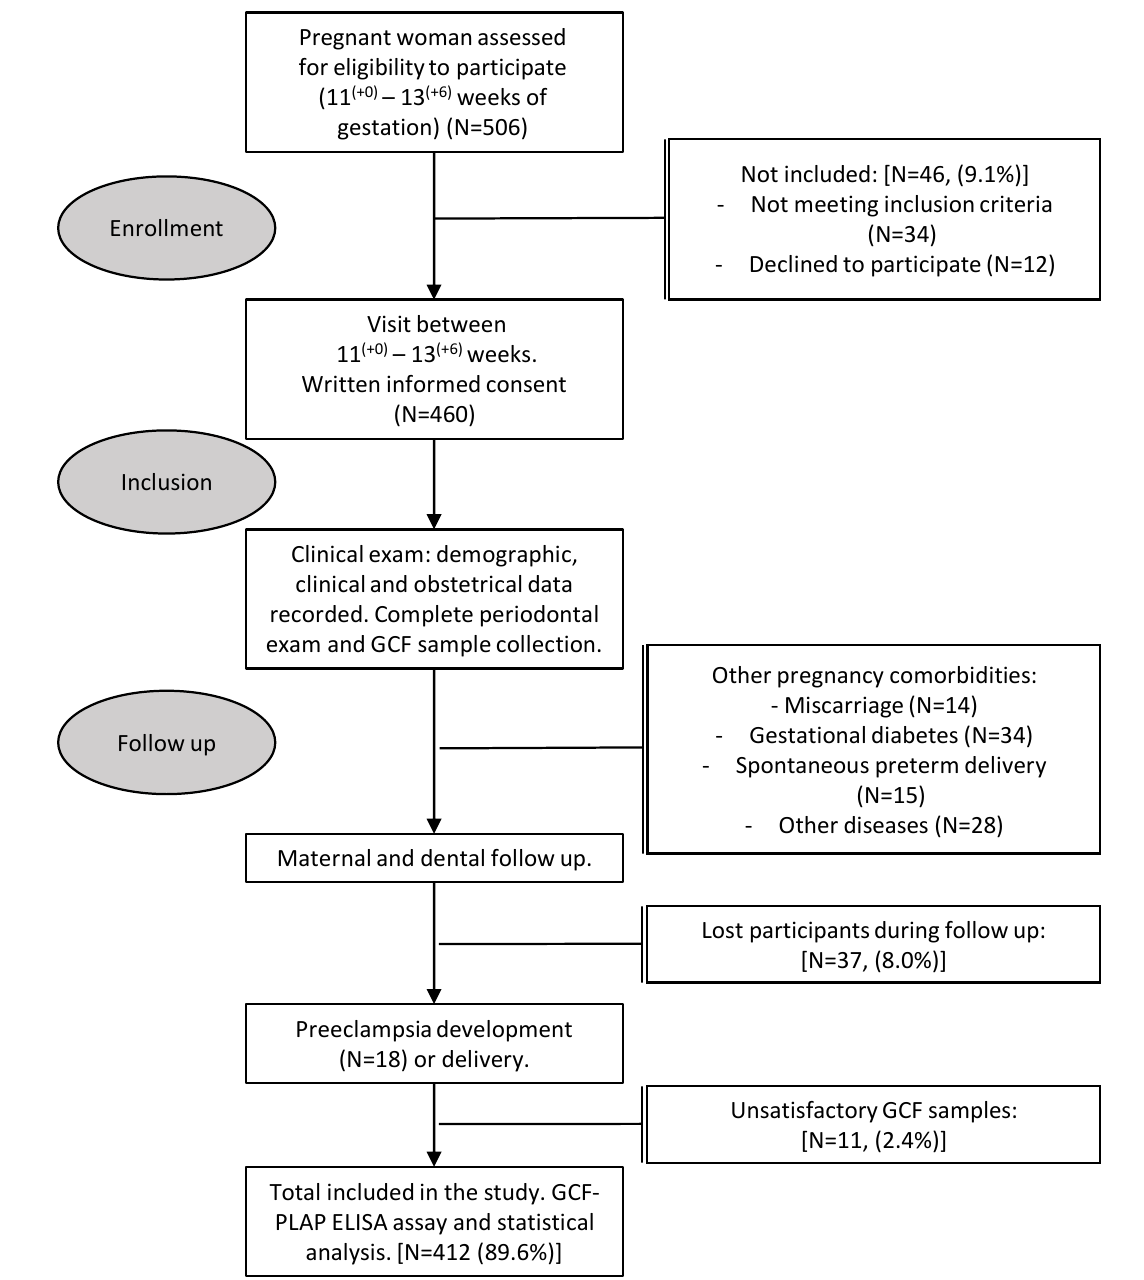
Figure 1. Flow chart of the study population.